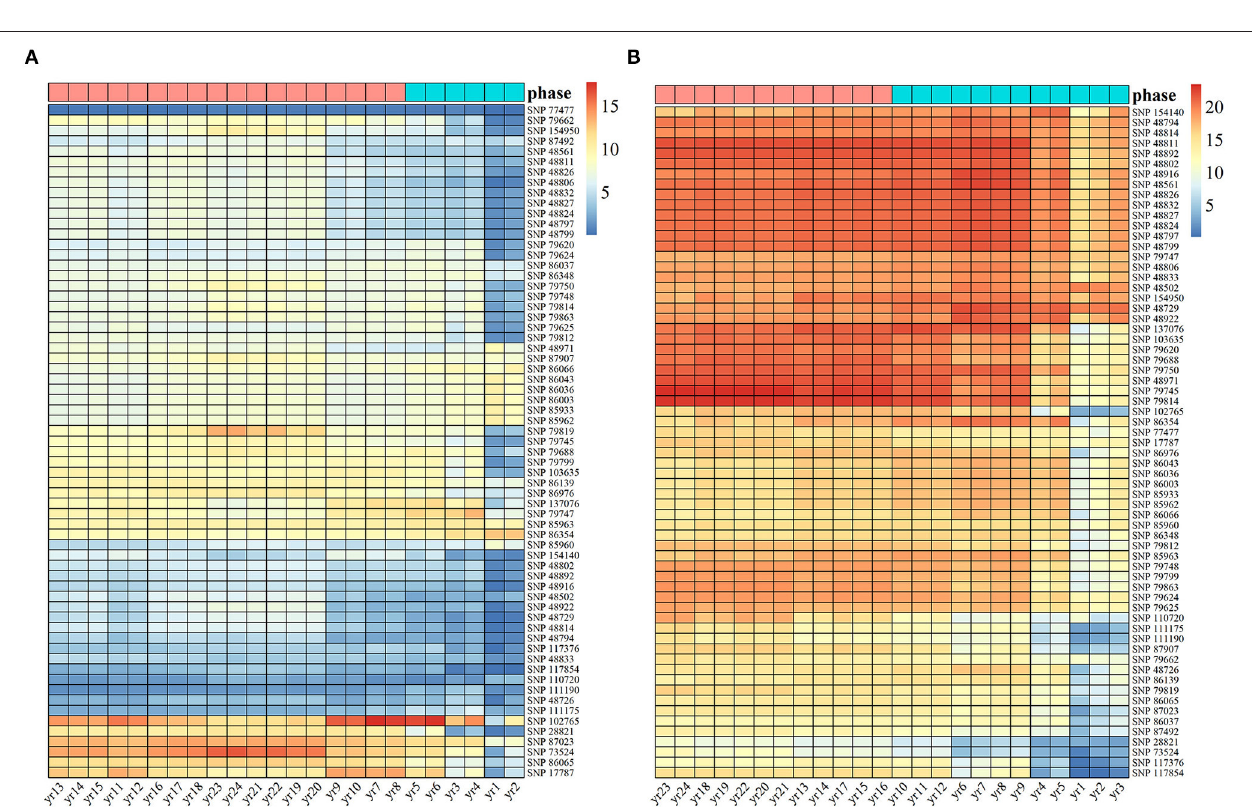
FIGURE 3 | Heat maps of heritability are explained by 65 significant SNPs of Populus. The temporal patterns of heritability for (A) stem height and (B) stem diameter at 24 years were clustered into two phases, with blue representing the first phase and pink representing the second phase.